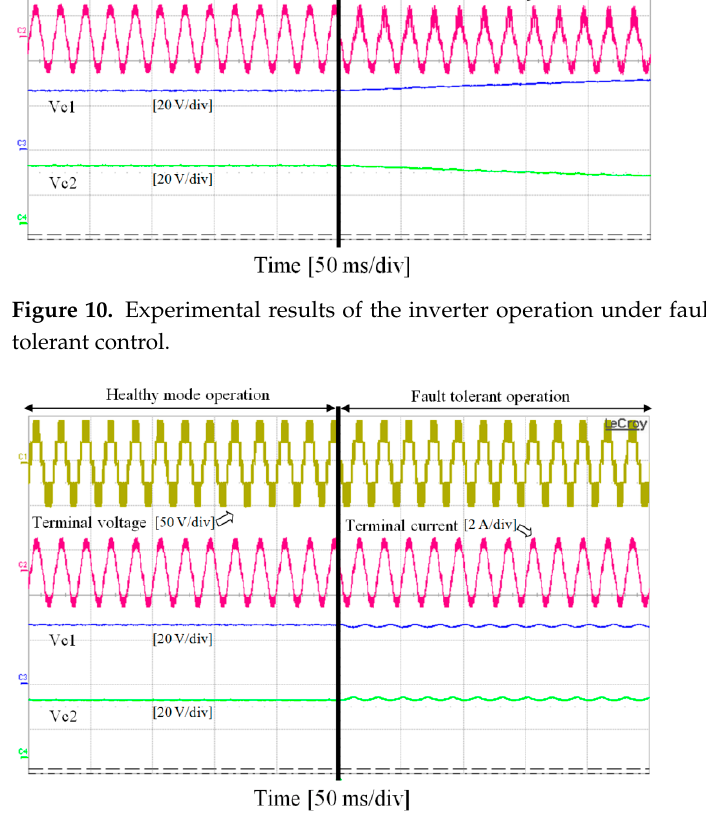
Figure 11. Experimental results of the inverter operation with fault-tolerant control in case of fault event in D c4 .